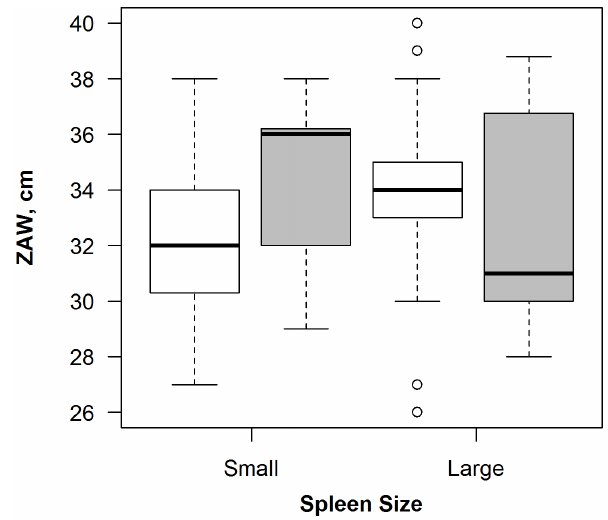
Figure 2. Effect of ZAW (cm), and spleen size (Small, Large) on prevalence of SQPV in males. Non-infected individuals are denoted by open bars, infected individuals by dark bars. Plot ‘‘whiskers’’ denote maximum and minimum values, and ‘‘box’’ shows upper and lower quartiles and the median. Outliers are shown as open circles and are defined as datapoints which lie outside the range of the upper quartile + 1.5 times the interquartile range, or the lower quartile 2 1.5 times the interquartile range.